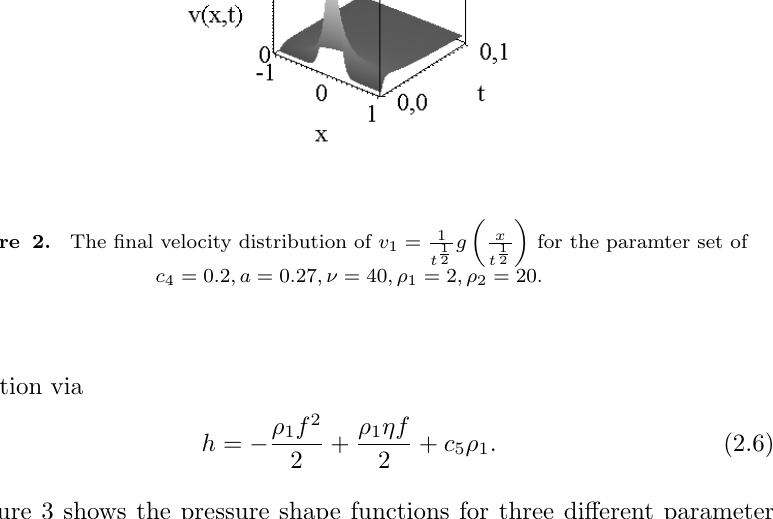
Figure 2. The final velocity distribution of v 1 = 1